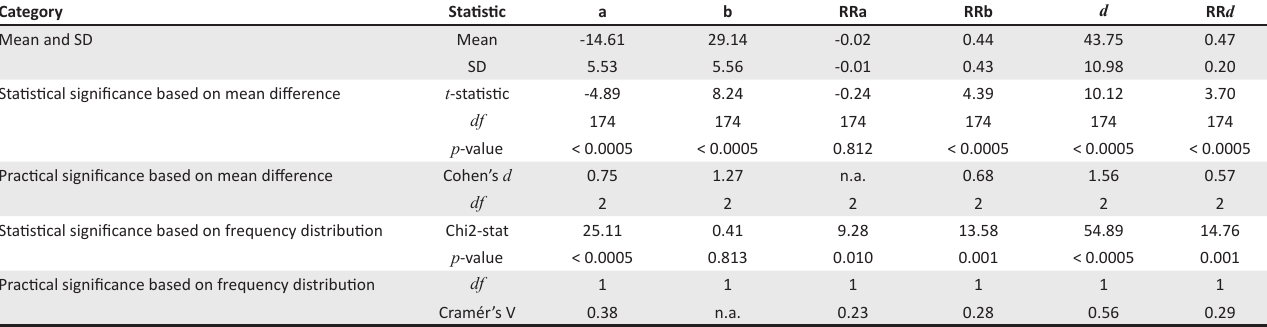
TABLE 2: Experimental minus comparison groups’ scores (mean difference). Category